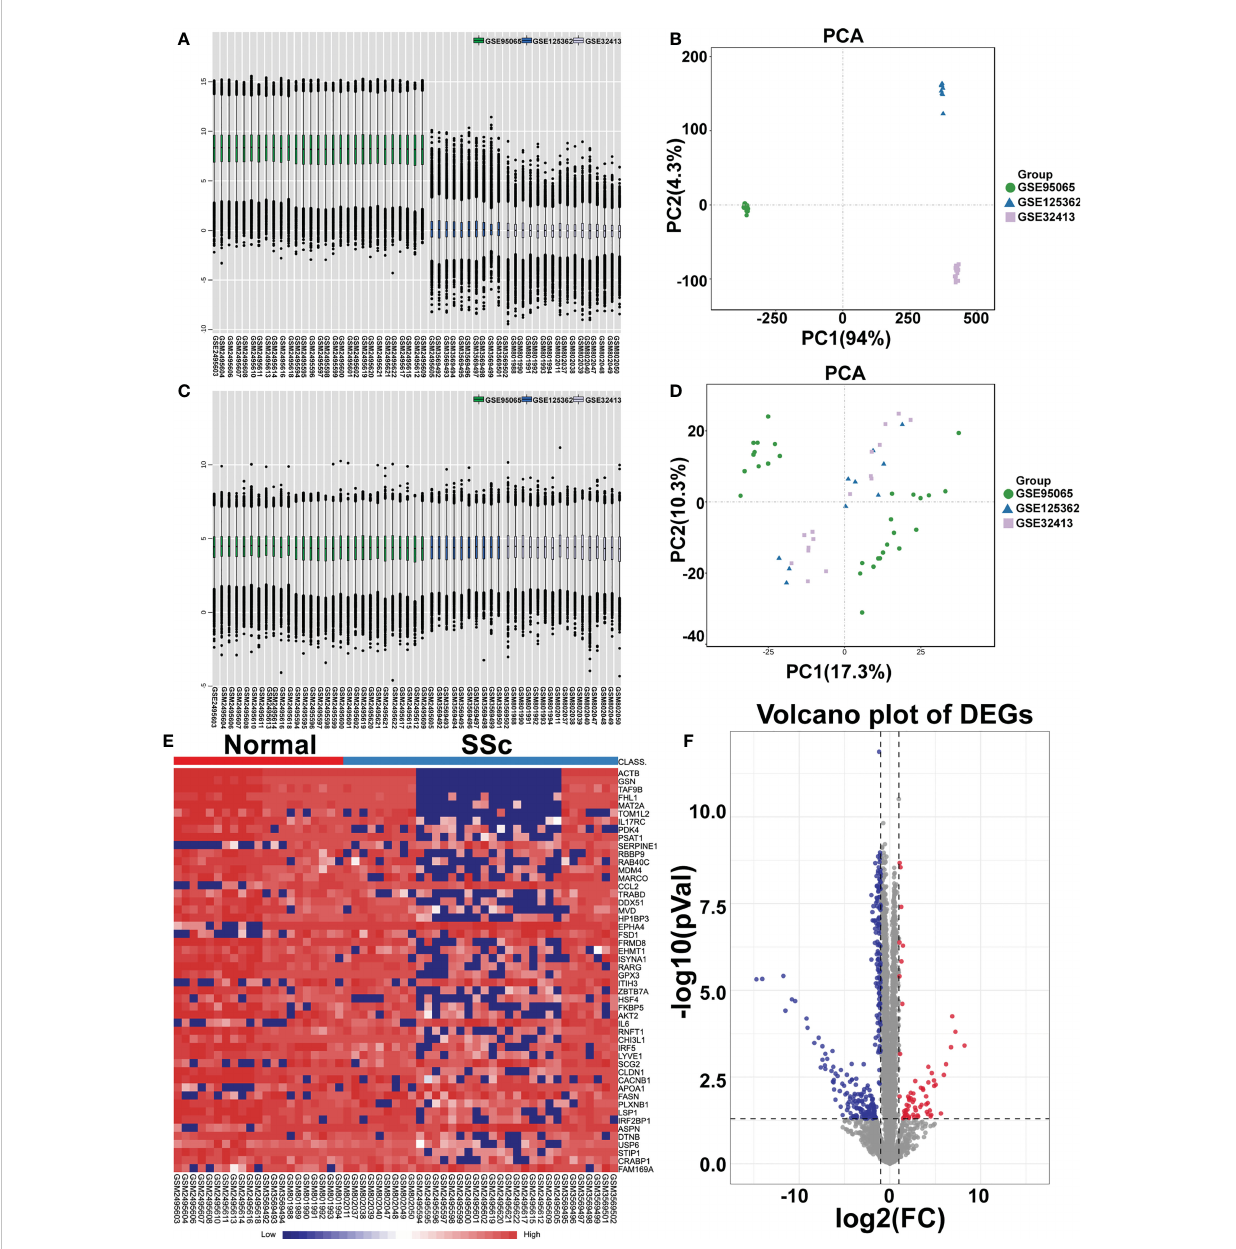
FIGURE 1 Identi fi cation of differentially expressed mRNAs (DEGs). Box plot and principal component analyses were applied to remove batch correction of GSE95065, GSE125362, and GSE32413. (A, B) Before batch correction and (C, D) After batch correction. (E) Heatmap of DEGs between the SSc group and the normal group (red represents high expression; blue represents low expression). (F) Volcano plot of DEGs between the SSc group and the normal group. The red plots represent upregulated genes, the blue plots represent downregulated genes, the black plots represent nonsigni fi cant